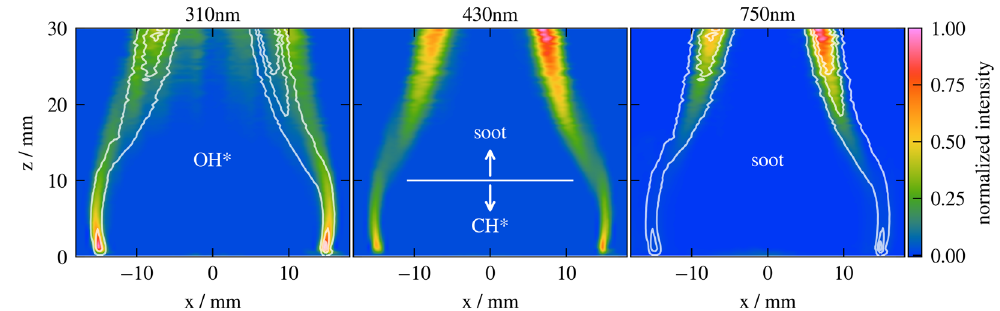
Figure 10. Vertical slices ( y = 0 mm) of the time-averaged intensity distributions of a laminar methane / air di ff usion flame at 310, 430 and 750 nm ( λ 1 = 5, λ 2 = 10, CH 4 2 slm, air 10 slm). The white solid lines are 10%, 40% and 60% iso-contour lines of the distribution at 430